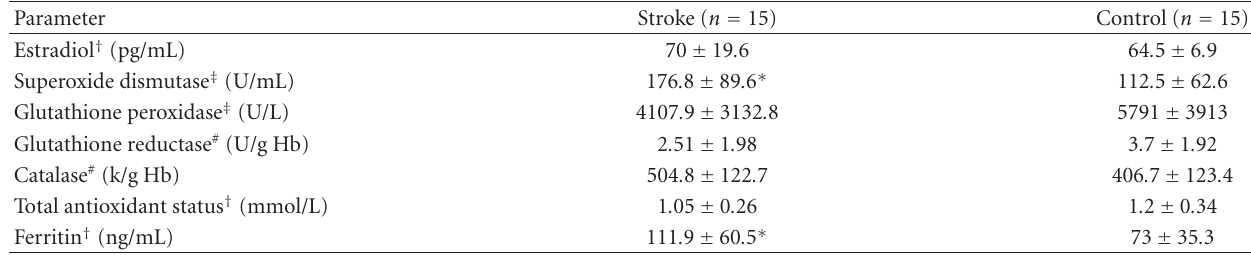
Table 2: The mean ± SD values of the estradiol, ferritin and total antioxidant status, superoxide dismutase and glutathione peroxidase, glutathione reductase and catalase of the males from stroke and control